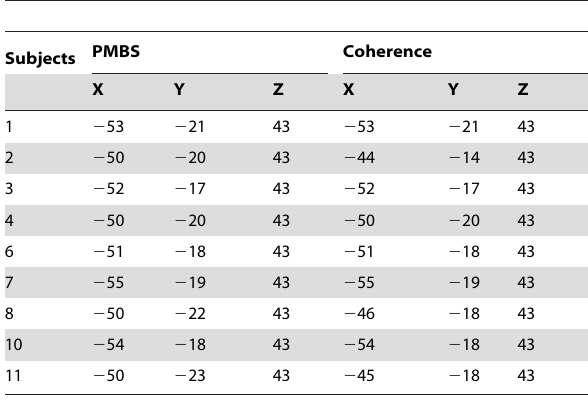
Table 4. MNI co-ordinates of the voxels with the maximum PMBS and maximum coherence in